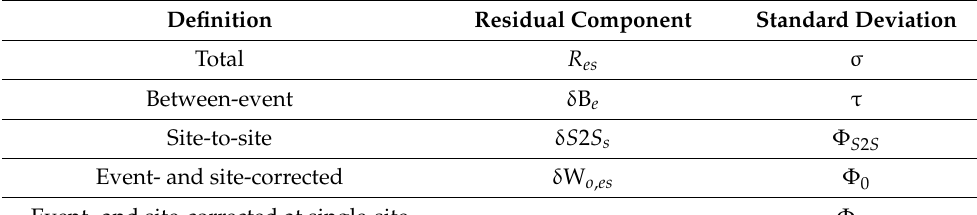
Table 1. Residual components and corresponding standard deviations (modified after [34]).